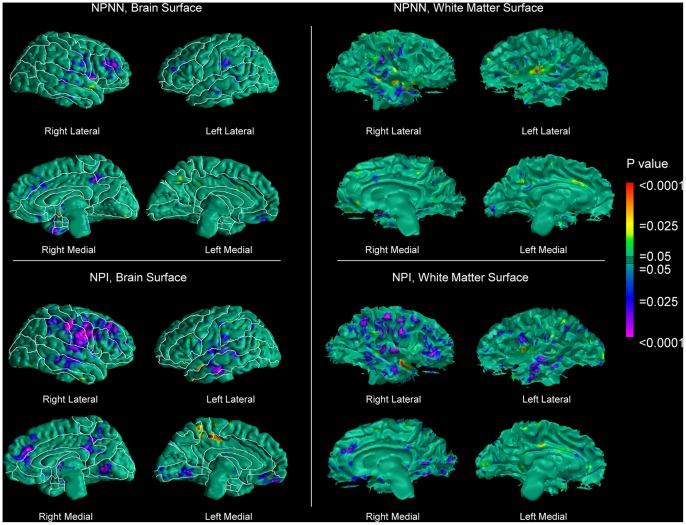
Maps of Group Differences in Local Volumes along the Surface of the Brain and of the Underlying WM Across Cognitive Subgroups.Statistical effects are color-encoded as in Fig. 1 and subgroup definitions are the same as in Fig. 2. Results are GRF-corrected. Reductions in local volumes of brain tissue along the surface of the brain and of the WM in perisylvian regions are more prominent and more extensive in the NPI group. (Upper Left) Comparisons of the brain surface of NPNN patients with that of healthy controls. (Lower Left) Comparisons of the brain surface of NPI patients with that of healthy controls. (Upper Right) Comparisons of the WM surface of NPNN patients with that of healthy controls. (Lower Right) Comparisons of the WM surface of NPI patients with that of healthy controls. Neuropsychologically impaired patients show a higher burden of anatomical abnormalities than neuropsychologically near-normal patients. Reductions of local volumes of brain tissue along the surface of the brain corresponded to reductions in local volumes along the surface of the underlying WM.